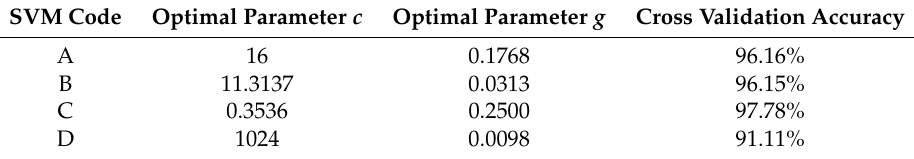
Table 5. The results of parameter optimization under different SVM